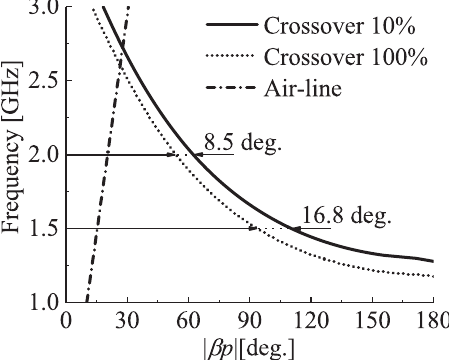
Fig. 12. Dispersion diagram of the unit cell with l =8 mm, g = 0.5mm, p =8.5 mm, w =3 mm, r =0.25mm, h = 8mm, l pp = 2.9 mm, d